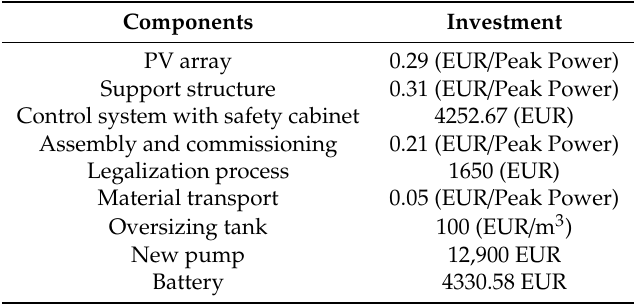
Table 2. Costs for calculating